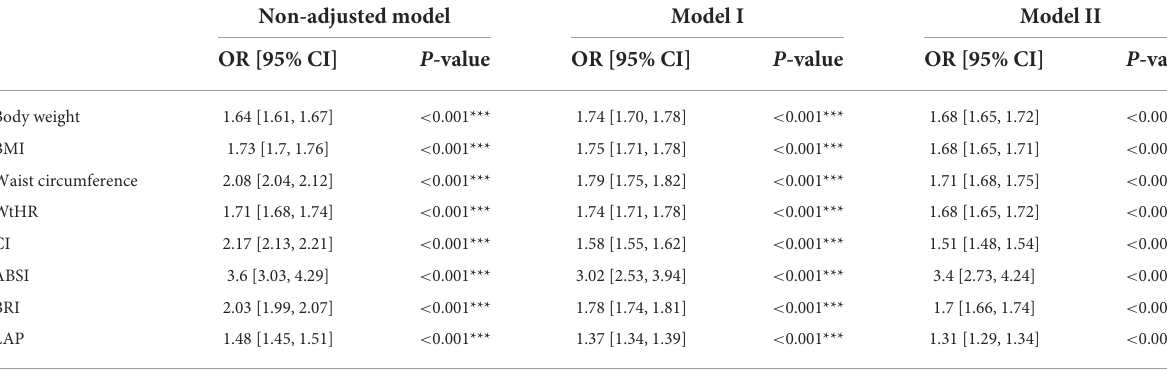
TABLE 2 Logistic regression analysis of anthropometric measures and hypertension.